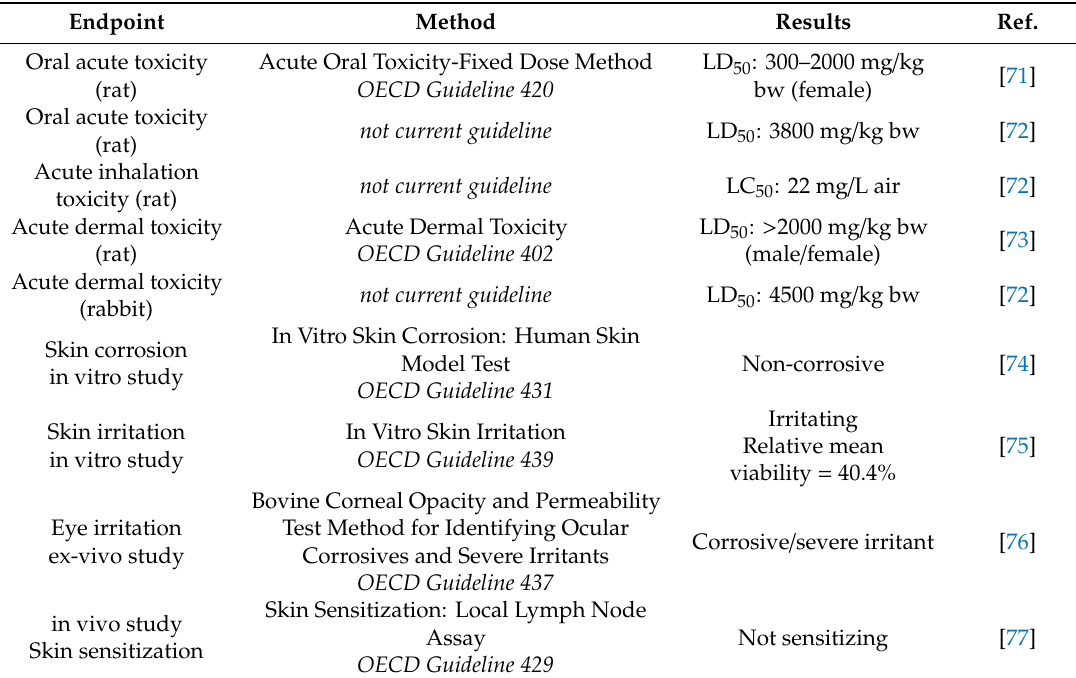
Table 5. Summary of the studies assessing acute toxicity and